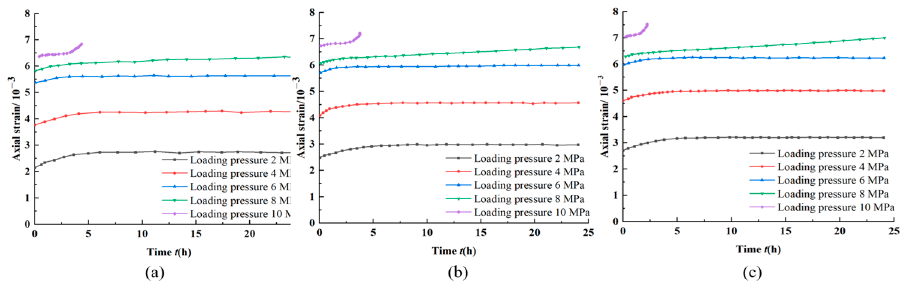
Figure 11. Creep deformation curves of different pore water pressure and the same porosity classi- fication; ( a ) the pore water pressure is 0.5 MPa; ( b ) the pore water pressure is 1.0 MPa; ( c ) the pore water pressure is 1.25 MPa.